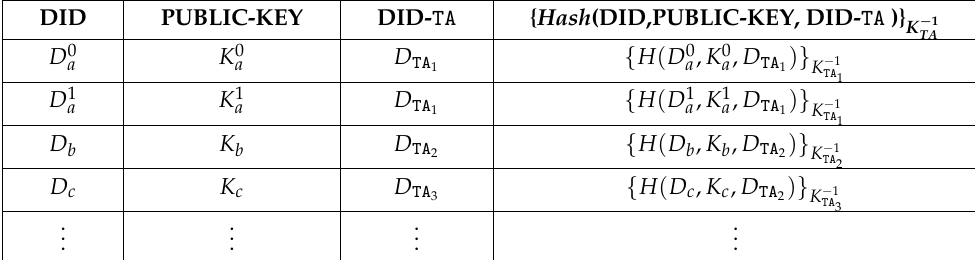
Table 3. Links between DIDs and public keys in Hyperledger Indy.